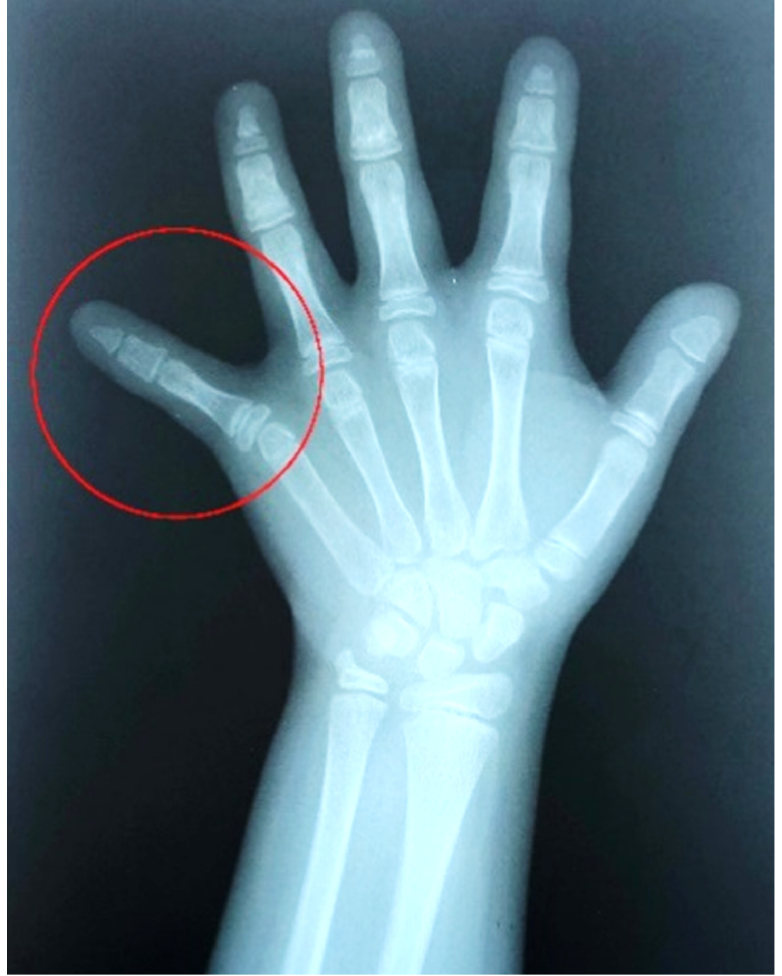
Figure 4. Initial 10/04/2008 left hand X-ray (10-year-old): joint alteration of the fifth finger of the left hand (red circle).